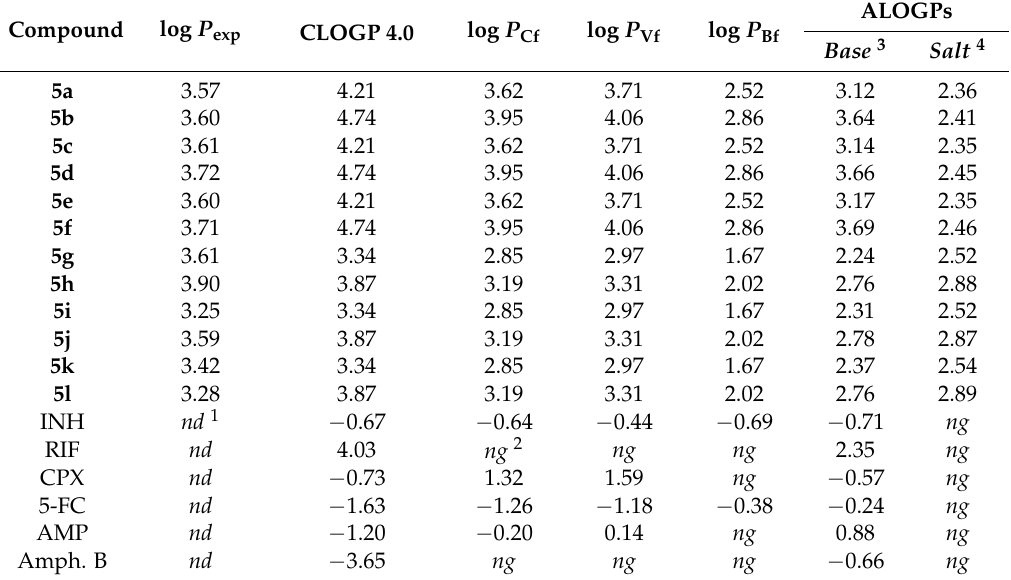
Table 2. Experimentally observed values of the partition coefficient (log P exp ) of the compounds 5a – l in the octan-1-ol/phosphate buffer (p H = 7.4) system and in silico predicted readouts for corresponding non-protonated bases and the reference drugs isoniazid (INH), rifampicin (RIF), ciprofloxacin (CPX), 5-flucytosine (5-FC), ampicillin (AMP) and amphotericin B (Amph. B), respectively, by CLOGP method (CLOGP 4.0), Ghose and Crippen (cid:48) s approach (log P Cf ), Viswanadhan (cid:48) s approach (log P Vf ), Broto (cid:48) s algorithm (log P Bf ) and ALOGPs method.